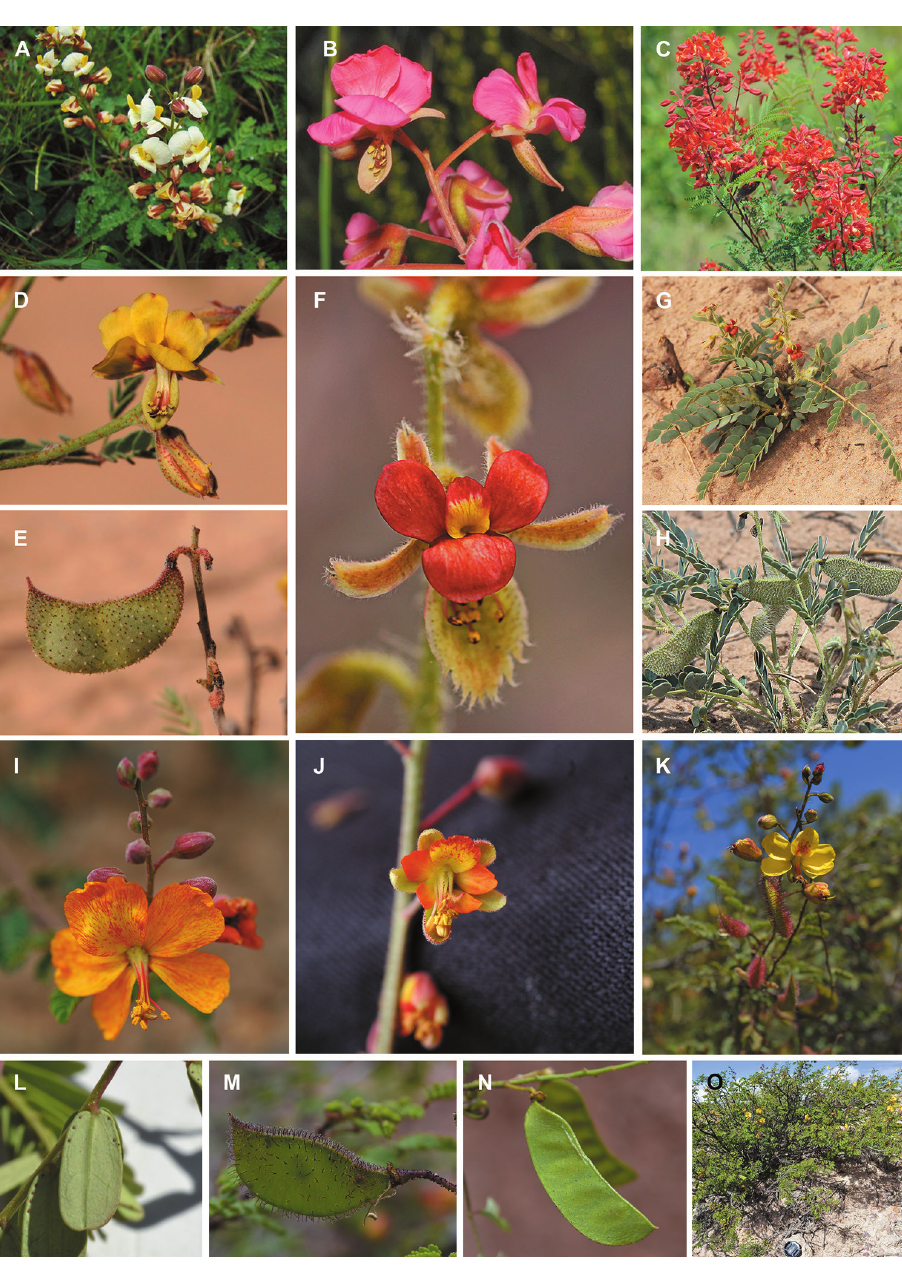
Figure 39. Pomaria pilosa (Vogel) B. B. Simpson & G. P. Lewis. A inflorescences (A. A. Schneider, Flora Digital (http://www.ufrgs.br/fitoecologia/florars/), Rio Grande do Sul, Brazil, unvouchered ). Pomaria rubi- cunda (Vogel) B. B. Simpson & G. P. Lewis B flowers C inflorescences (S. Bordignon, Flora Digital (http:// www.ufrgs.br/fitoecologia/florars/), Rio Grande do Sul, Brazil, unvouchered ). Pomaria jamesii (Torr. & Gray) Walp. D flower E fruit (P. Alexander, SEINet Arizona Chapter (http://swbiodiversity.org/seinet/ imagelib/), Arizona, USA, unvouchered ); Pomaria burchellii (DC.) B. B. Simpson & G. P. Lewis